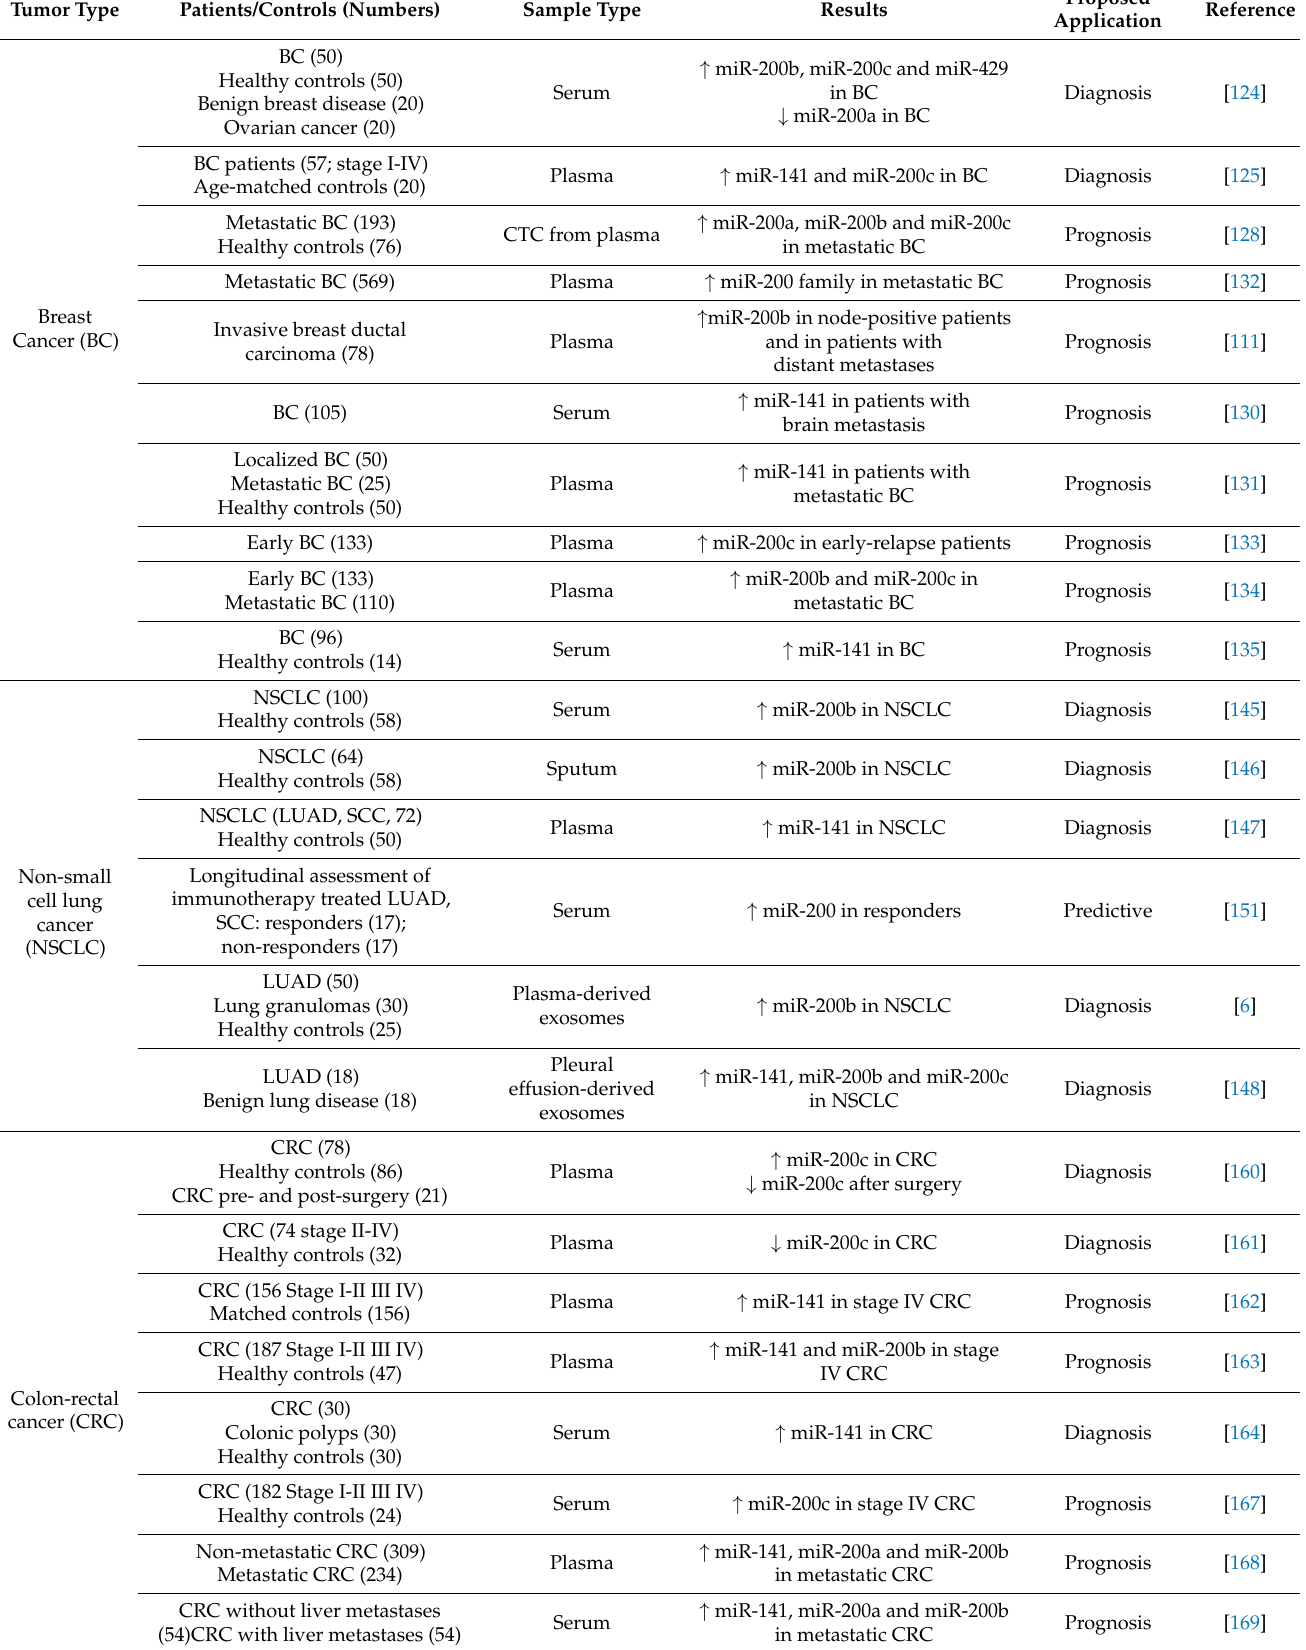
Table 1. The clinical value of circulating miR-200 family members in breast, lung, colorectal, ovarian, prostate and bladder cancers. For studies that included discovery and validation steps, only the validation data are